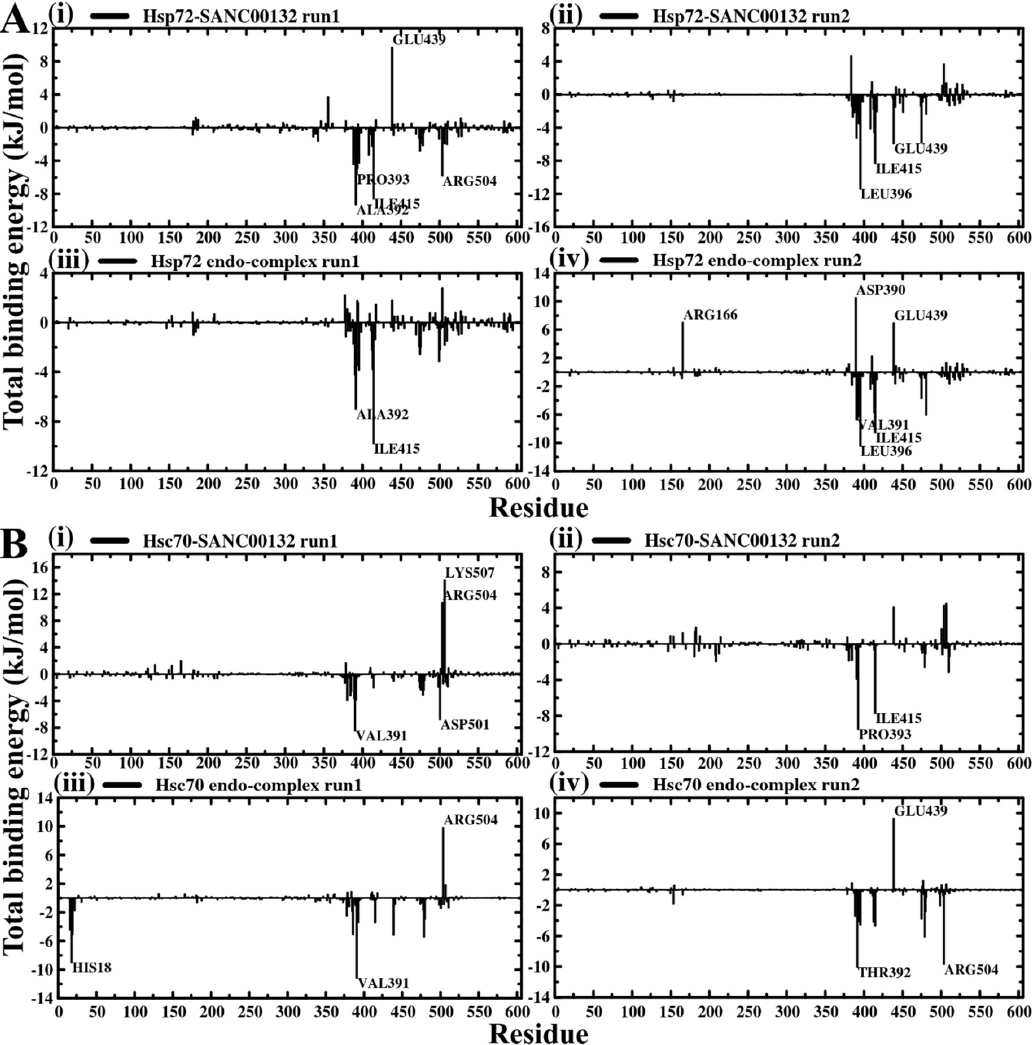
Figure 4. Bar plots showing per residue contribution to total binding free energy. ( A ) Hsp72 SANC00132-bound complexes. ( B ) Hsc70 SANC00132-bound complexes. All residues contributing more than +/ − 5 kJ · mol − 1 are listed in Table S7.